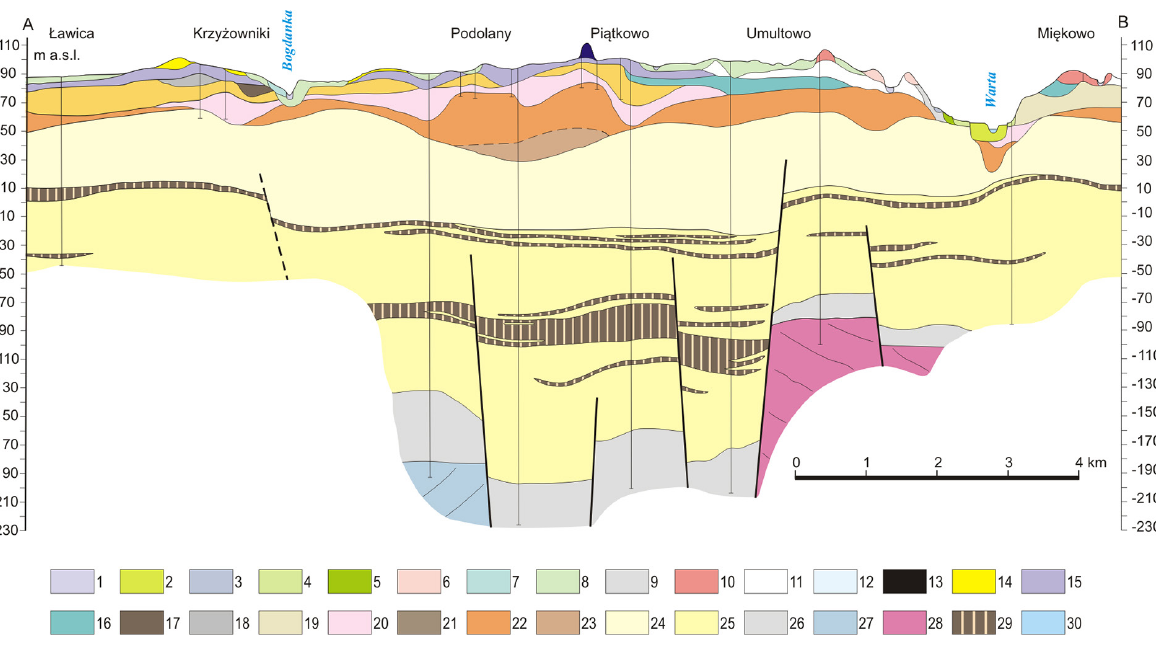
Fig. 3. Geological cross-section of the Warta River valley in Poznań (elaborated on the basis of detailed Geological Map of Poland by Chmal